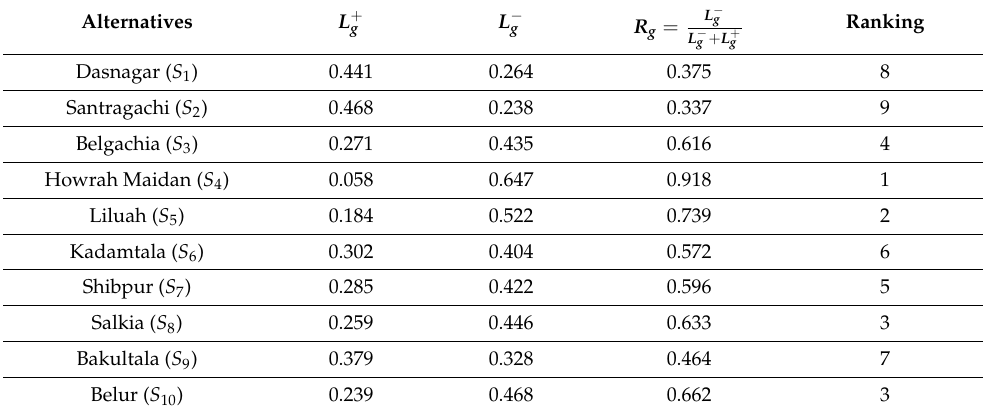
Table 10. Representation of distance measure, relative closeness and the ranking of sites.